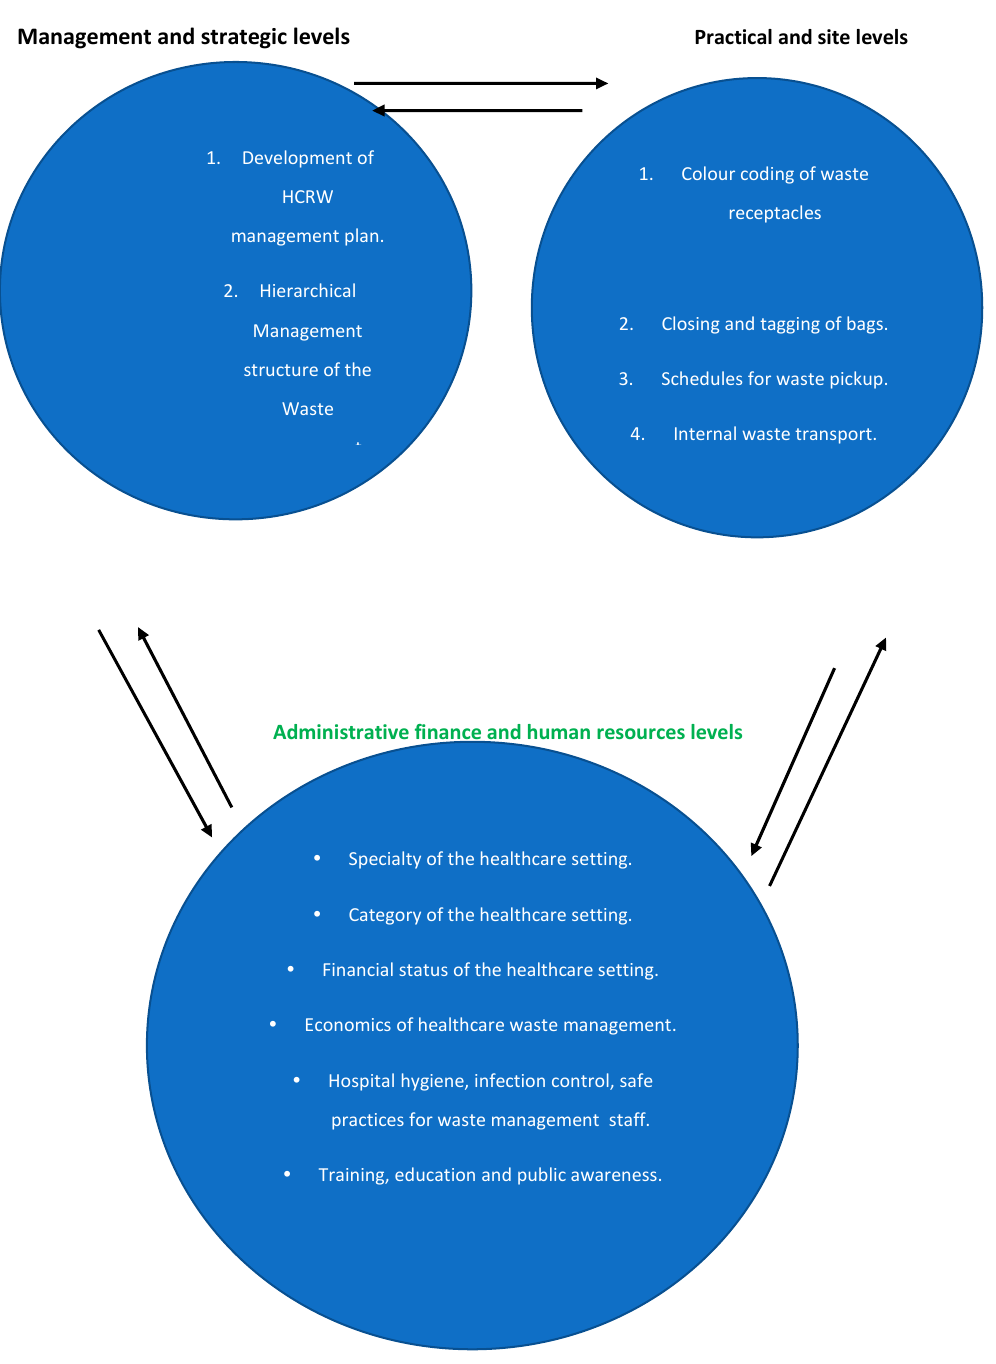
Figure 2. Components of levels for an effective HRCW management.